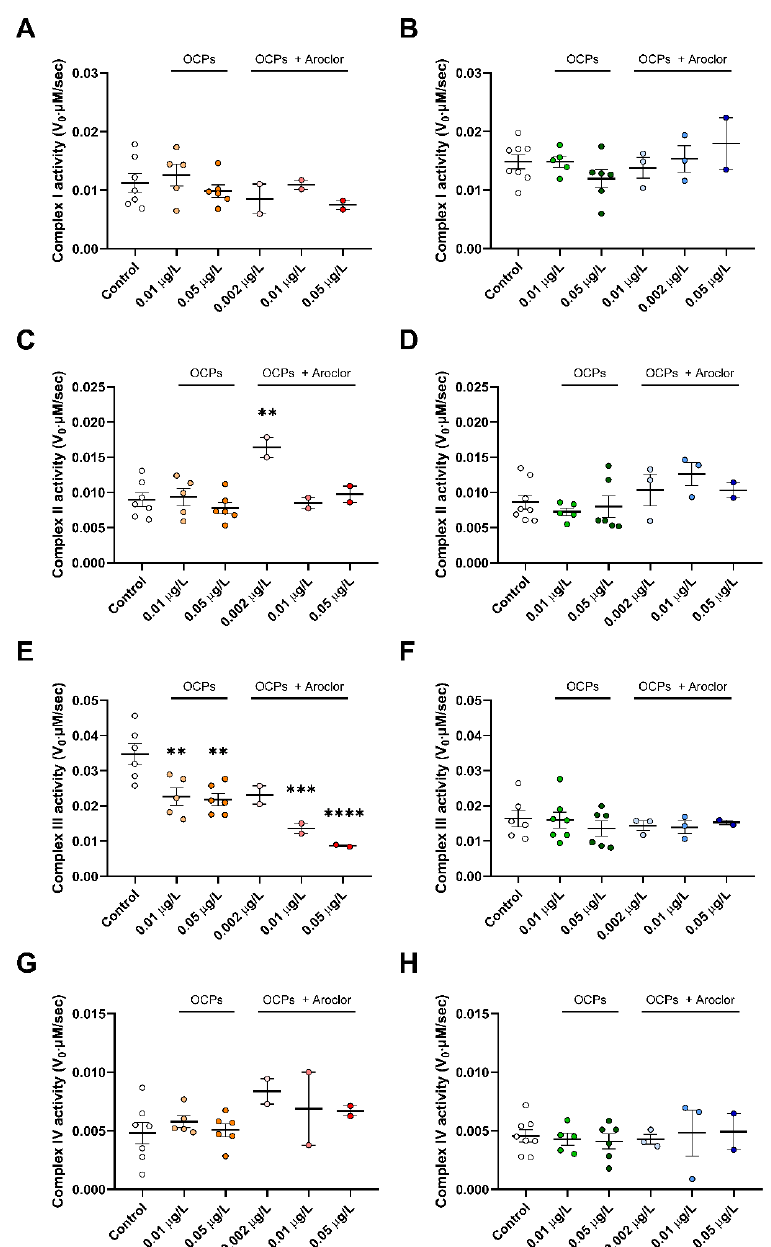
Figure 4. Mitochondrial complex I, II, III, and IV activities in the tails of female ( A , C , E , G ) and male ( B , D , F , H ) zebrafish exposed to POPs. Changes in absorbance were measured for 10 min at intervals of 10 s, and enzyme activities were calculated based on Equation (1). ( A , B ) Mitochondrial complex I activity. ( C , D ) Mitochondrial complex II activity. ( E , F ) Mitochondrial complex III activity. ( G , H ) Mitochondrial complex IV activity. Control groups are shown as white dots, 0.01 µ g/L organochlorine pesticide (OCP)-exposed females as yellow dots, 0.05 µ g/L OCP-exposed females as orange dots, 0.002 µ g/L OCP-and-Aroclor-exposed females as light pink dots, 0.01 µ g/L OCP-and-Aroclor-exposed females as pink dots, 0.05 µ g/L OCP-and-Aroclor-exposed females as red dots, 0.01 µ g/L OCP-exposed males as green dots, 0.05 µ g/L OCP-exposed males as dark green dots, 0.002 µ g/L OCP-and-Aroclor-exposed males as light blue dots, 0.01 µ g/L OCP-and-Aroclor-exposed males as blue dots, and 0.05 µ g/L OCP-and-Aroclor-exposed males as navy blue dots. Results are presented as the mean and S.E.M. Statistical analysis was performed using GraphPad Prism 8.0.1 software. One-way analysis of variance was used to compare to the control. ** p < 0.01, *** p < 0.001, and **** p < 0.0001 compared to the